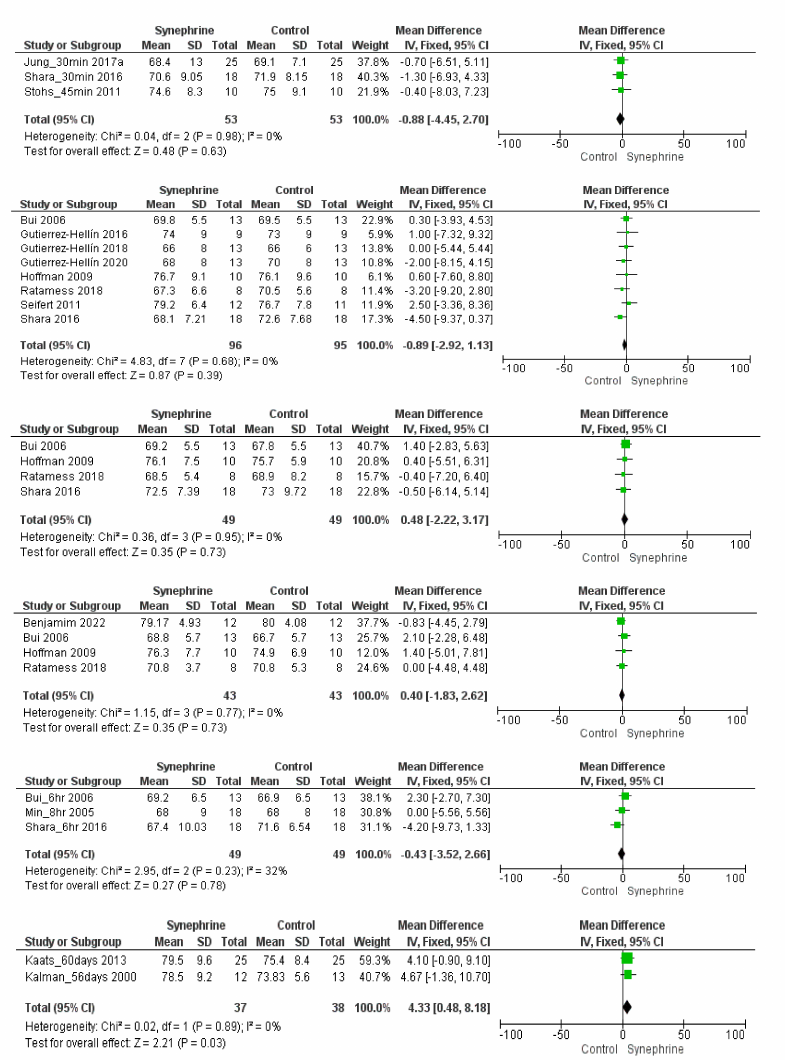
Figure 4. Forest plot diagram of synephrine on diastolic blood pressure acutely (after 30–45 min; 1 h; 2 h; 3 h; and 6–8 h) and long duration (56–60 days) in intervention and control groups. Overall, nine trials involving 129 persons with six different time durations and varying dosages of synephrine (range 20–214 mg) studied the effects of synephrine on heart rate. Significant differences between synephrine and the placebo were not reported; however, the heart rate slightly increased after 30 min–6 h from consumption in the synephrine group (Figure 5). It was found that 30–45 min after synephrine consumption (20–50 mg), the mean difference in heart rate was 3.15 beat/min (95% CI: − 0.41–6.71, p = 0.08); and it was 1.11 beat/min (95% CI: − 1.32–3.53, p = 0.37) 1 h after the consumption of varying doses (49–214 mg) of synephrine. After 2 h of the ingestion of 49–180 mg of synephrine, a non-significant rise in the heart rate was observed (MD 3.15 beat/min, 95% CI: − 0.65–6.96, p =